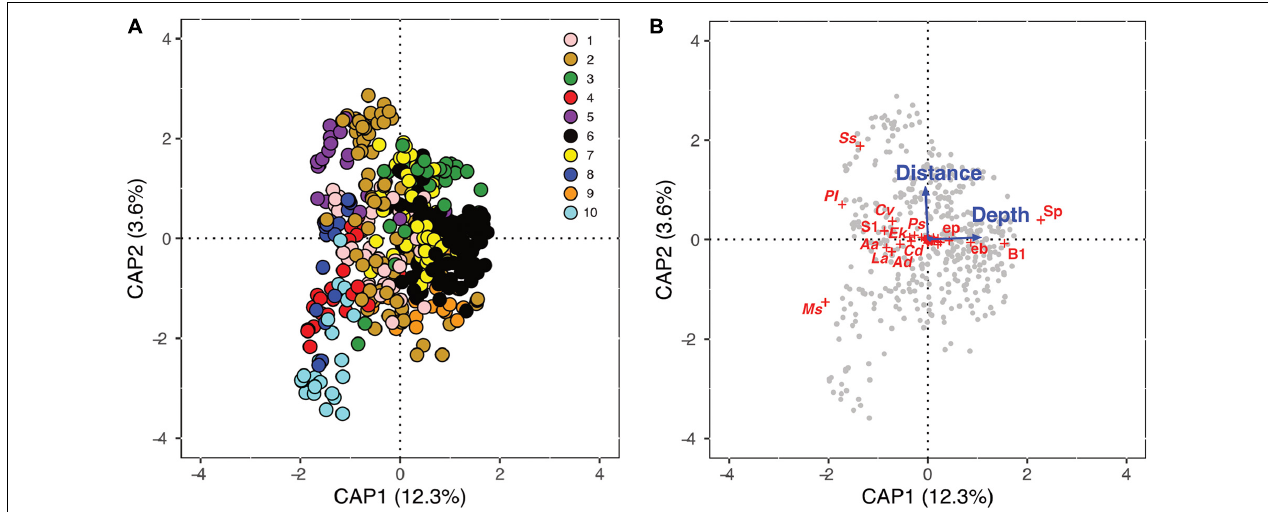
FIGURE 7 | Distance-based redundancy analysis (dbRDA). Results of the dbRDA performed over Bray–Curtis dissimilarity matrix of square-root transformed density data. Samples are represented as colored [ (A) ; color code is referred to Figure 6 ] or gray (B) dots, environmental variables represented as blue solid lines with arrows and species as red crosses. Names of the species with the highest scores are also shown in the biplot. Aa : Aulacomya atra , Ad : Arbacia dufresnii , B1: Brachiopoda 1, Cd : Crepipatella dilatata , Cv : Chaetopterus variopedatus , eb: encrusting bryozoans, Ek : Elminius kingii , ep: encrusting poriferans, La : Loxechinus albus , Ms : Metridium cfr. senile , Pl : Pentactella leonina , Ps : Psolus sp., S1: Sessilia 1, Sp: Spirorbinae, and Ss : Spiochaetopterus